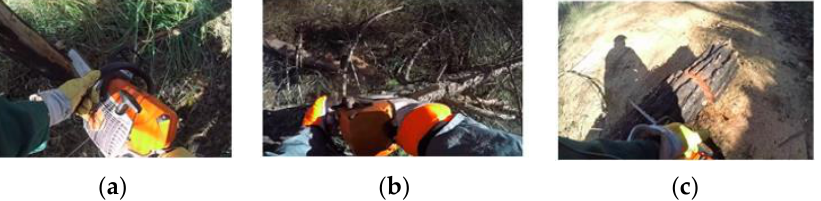
Figure 1. A worker performing the 3 main tasks of tree felling ( a ), tree delimbing ( b ), and tree bucking ( c ).